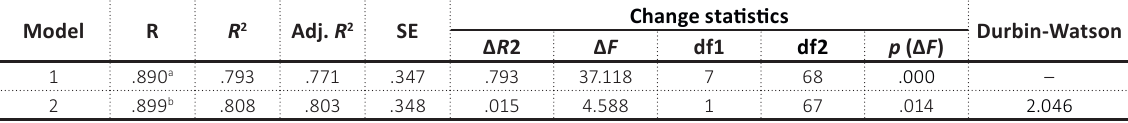
Table 8. Hierarchical regression model summary Model